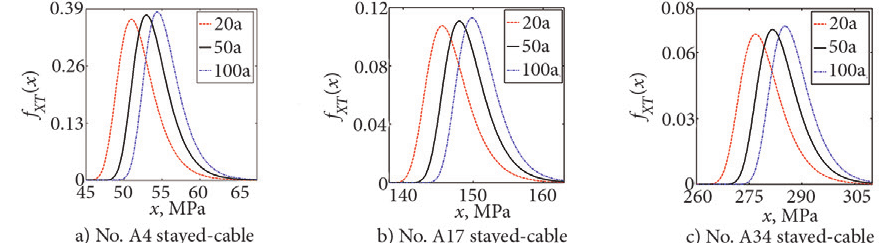
Fig. 11. The curves of probability density of maximum cable stress for different service life under vehicle